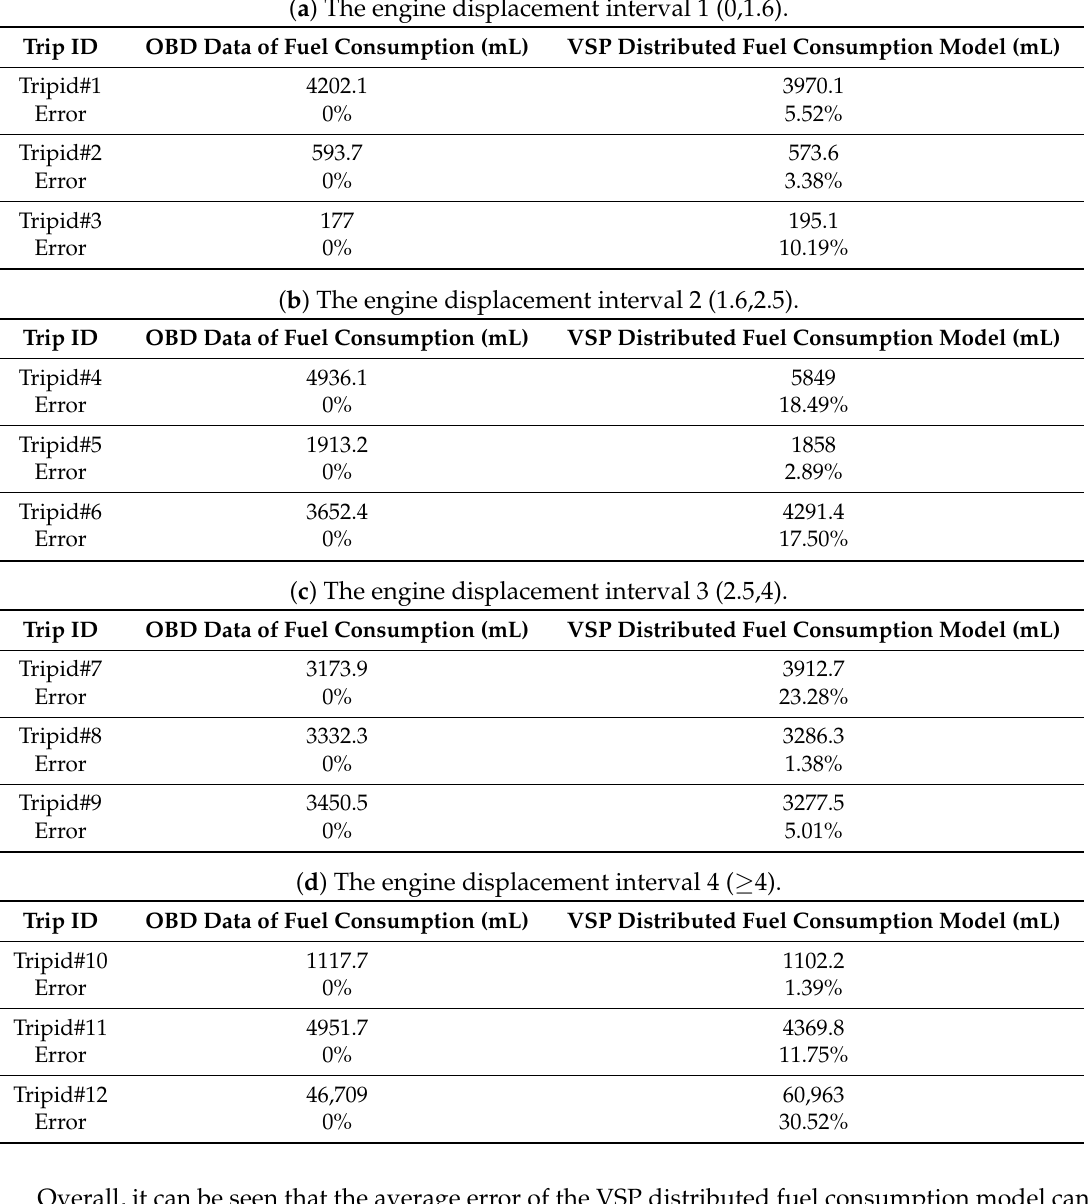
Table 8. Comparisons of fuel consumption.